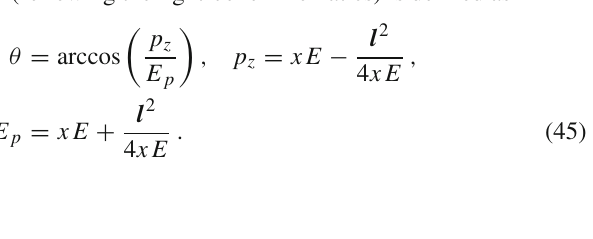
Fig. 6 The gluon (left) and quark (right) k T vs. x distributions for cascades initiated by quarks with w( l ) ∝ 1 / [ l 2 ( m 2 t = 0 . 1 , 1 ,